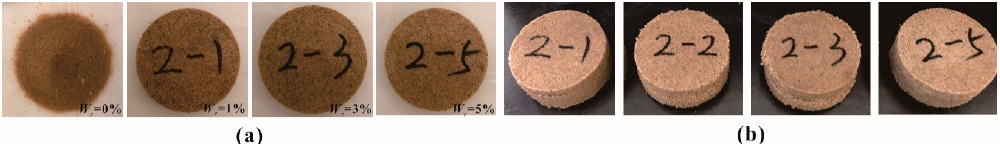
Figure 4. The shape of the polymer-sand composite material for different periods: ( a ) After immersion for 48 h; ( b ) After carrying out the direct shear test. Table 3. The direct shear test results of the specimens after immersion.